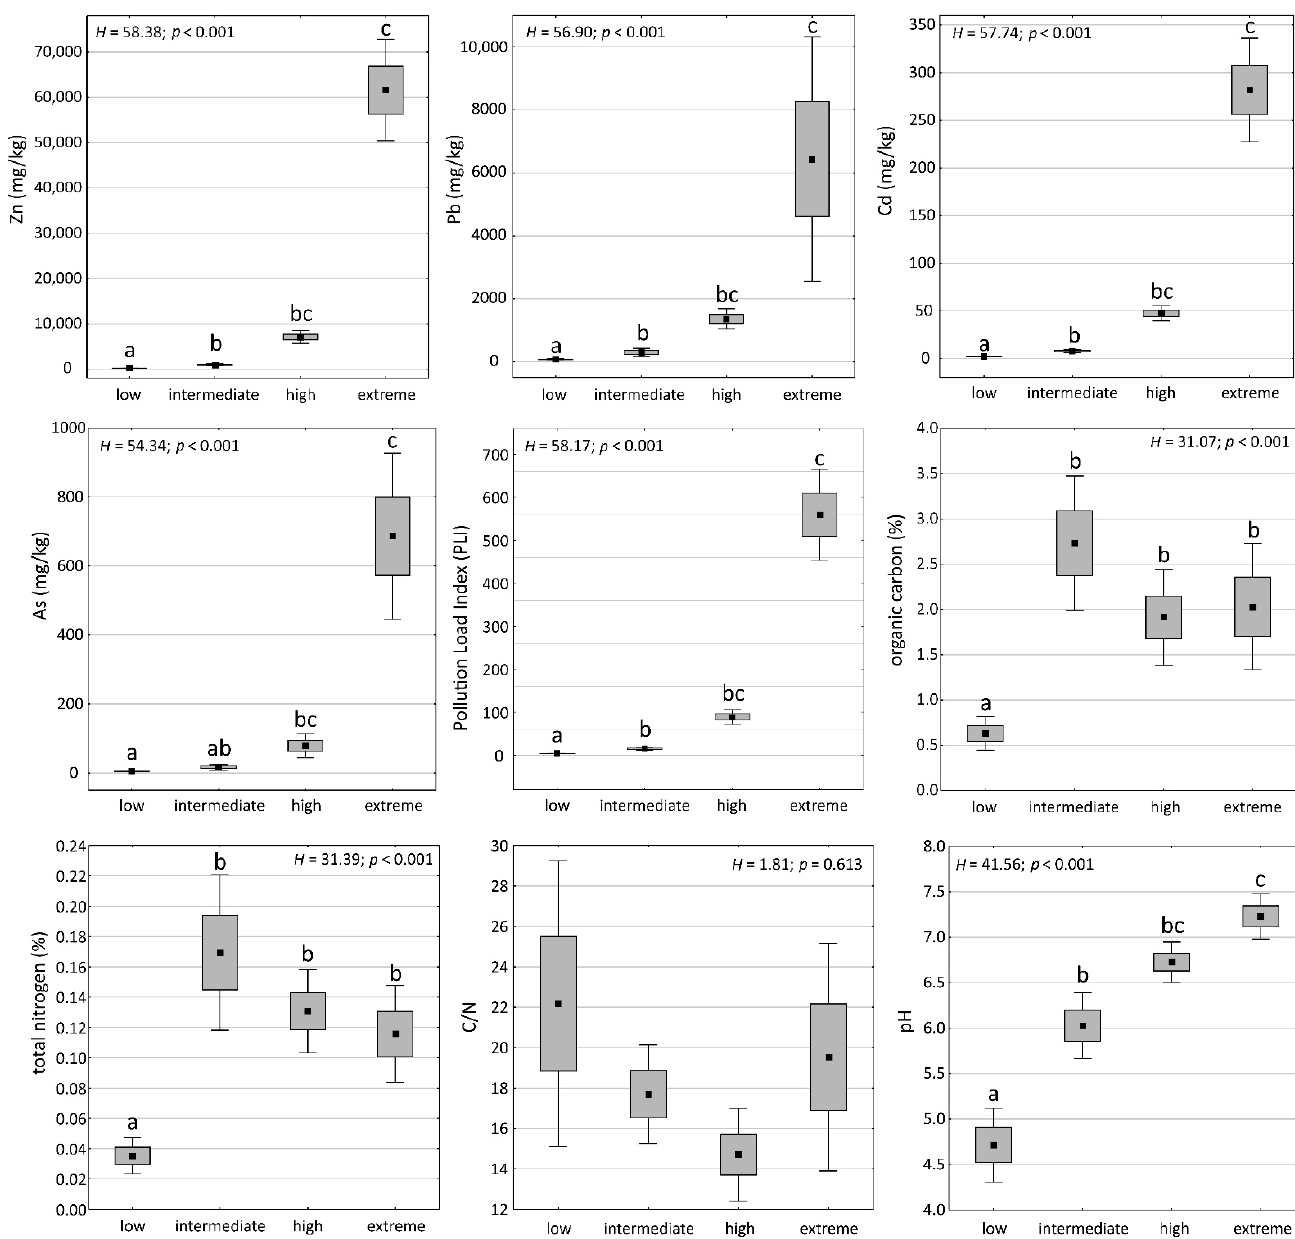
Figure 2. Box-and-whisker plots of soil chemical parameters and pollution load index (PLI) for particular soil condition classes. The points indicate means, boxes indicate standard errors, and whiskers 95% confidence intervals. The results of Kruskal–Wallis test ( p < 0.05) are included: H and p -values. The letters denote the results of Dunn’s post hoc test; different letters indicate significant differences at the p < 0.05 level.